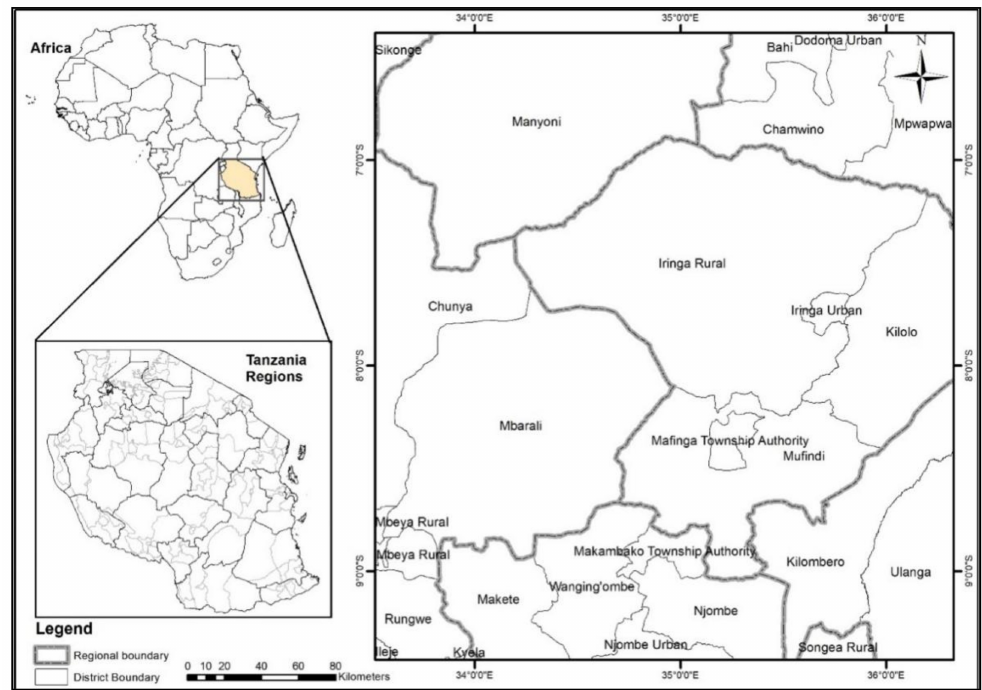
Figure 1. A map showing the study